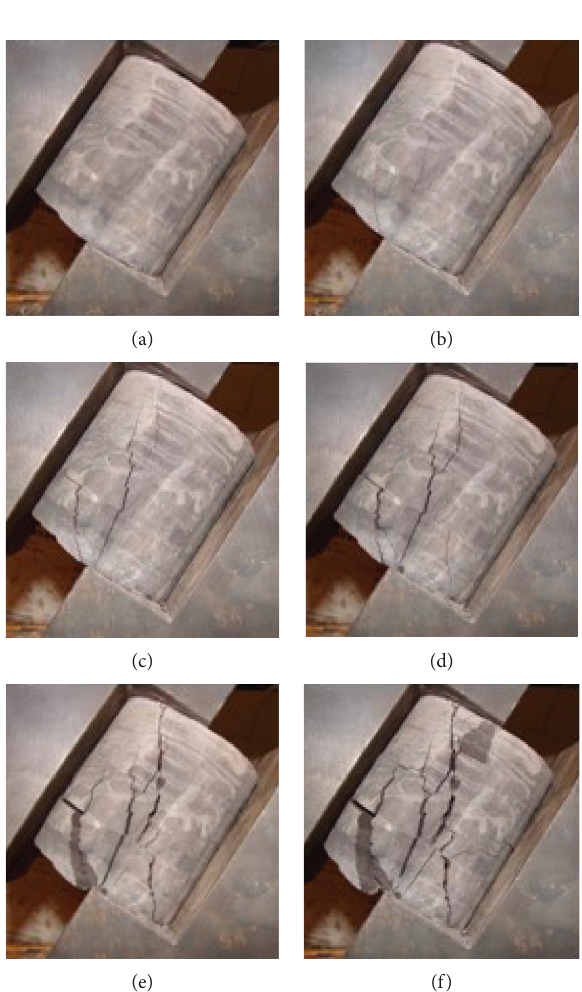
Figure 4: Inception and development process of fracture under compression and shear loading. (a) A point. (b) B point. (c) C point. (d) D point. (e) E point. (f) F